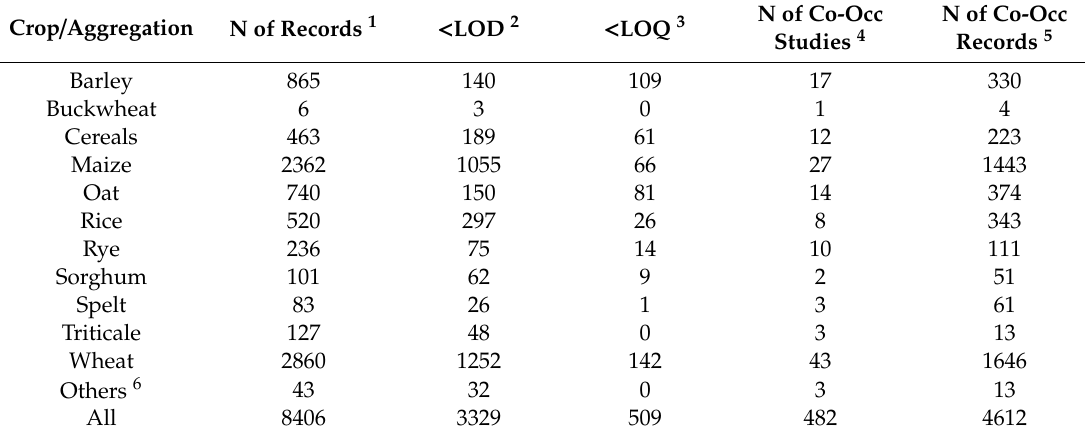
Table 1. Total number of records per crop with specification on the number of records below the limit of detection, the limit of quantification, and co-occurrence